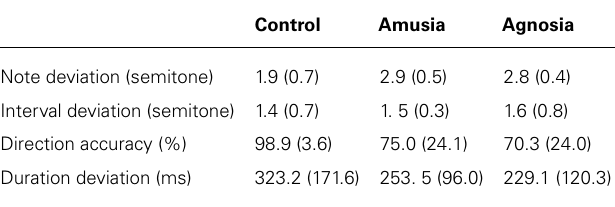
Table 3 |The music production performances among the three